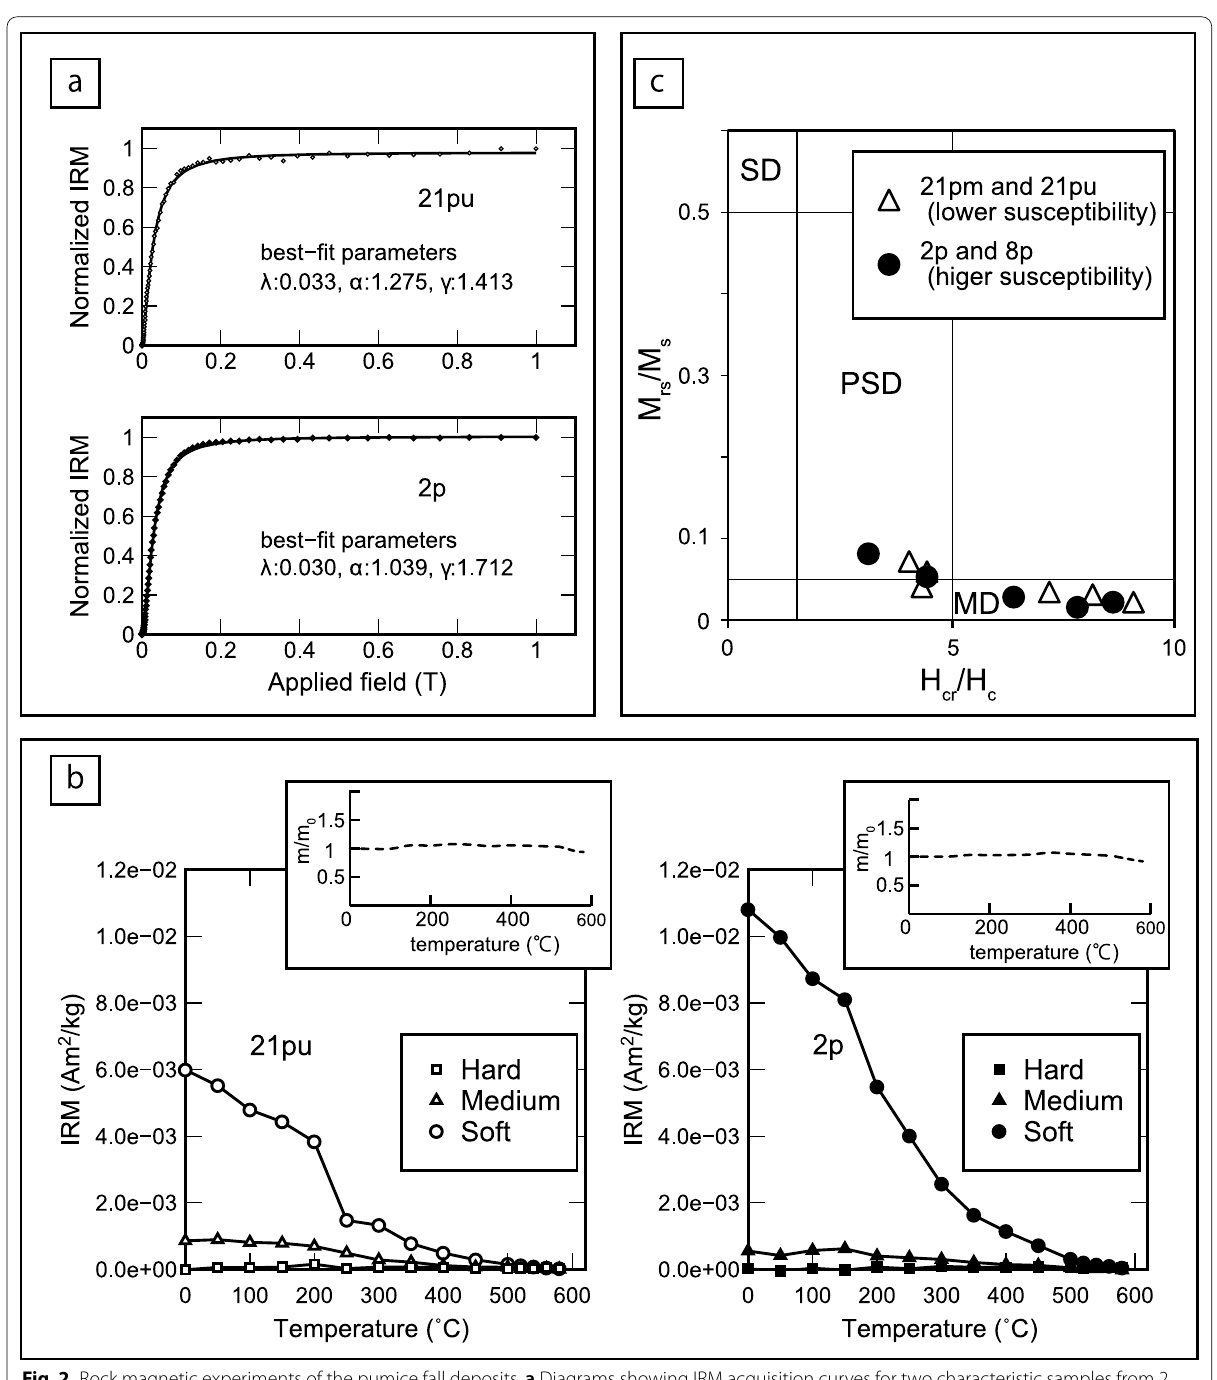
Fig. 2 Rock magnetic experiments of the pumice fall deposits. a Diagrams showing IRM acquisition curves for two characteristic samples from 2 and 21pu. Both curves can be closely fitted by a single component of a Burr type XII distribution (solid lines) following the protocol of Zhao et al. (2018). The best-fitting parameters are listed in the diagrams. b Results of the 3-axis IRM tests for units 2p and 21pu. The insets on the upper right show the change in MS during stepwise thermal demagnetization. The vertical axis of the inset represents the rate of change of MS. m 0 : unheated MS, m : MS in each step ( c ) Day plot for the pumice fall deposits (Day et al. 1977). M rs : saturation remanence, M s : saturation magnetization, H cr : remanent coercive force,